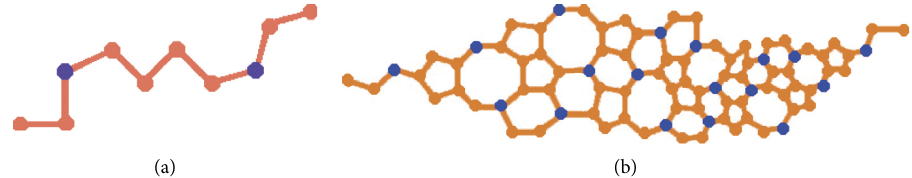
Figure 4: Two-dimensional structure of SiC 4 − II [ r , s ]. (a) a unit cell of SiC 4 − II [ r , s ]. (b) SiC 4 − II [ r , s ] for r (cid:28) 3, s (cid:28) 3.